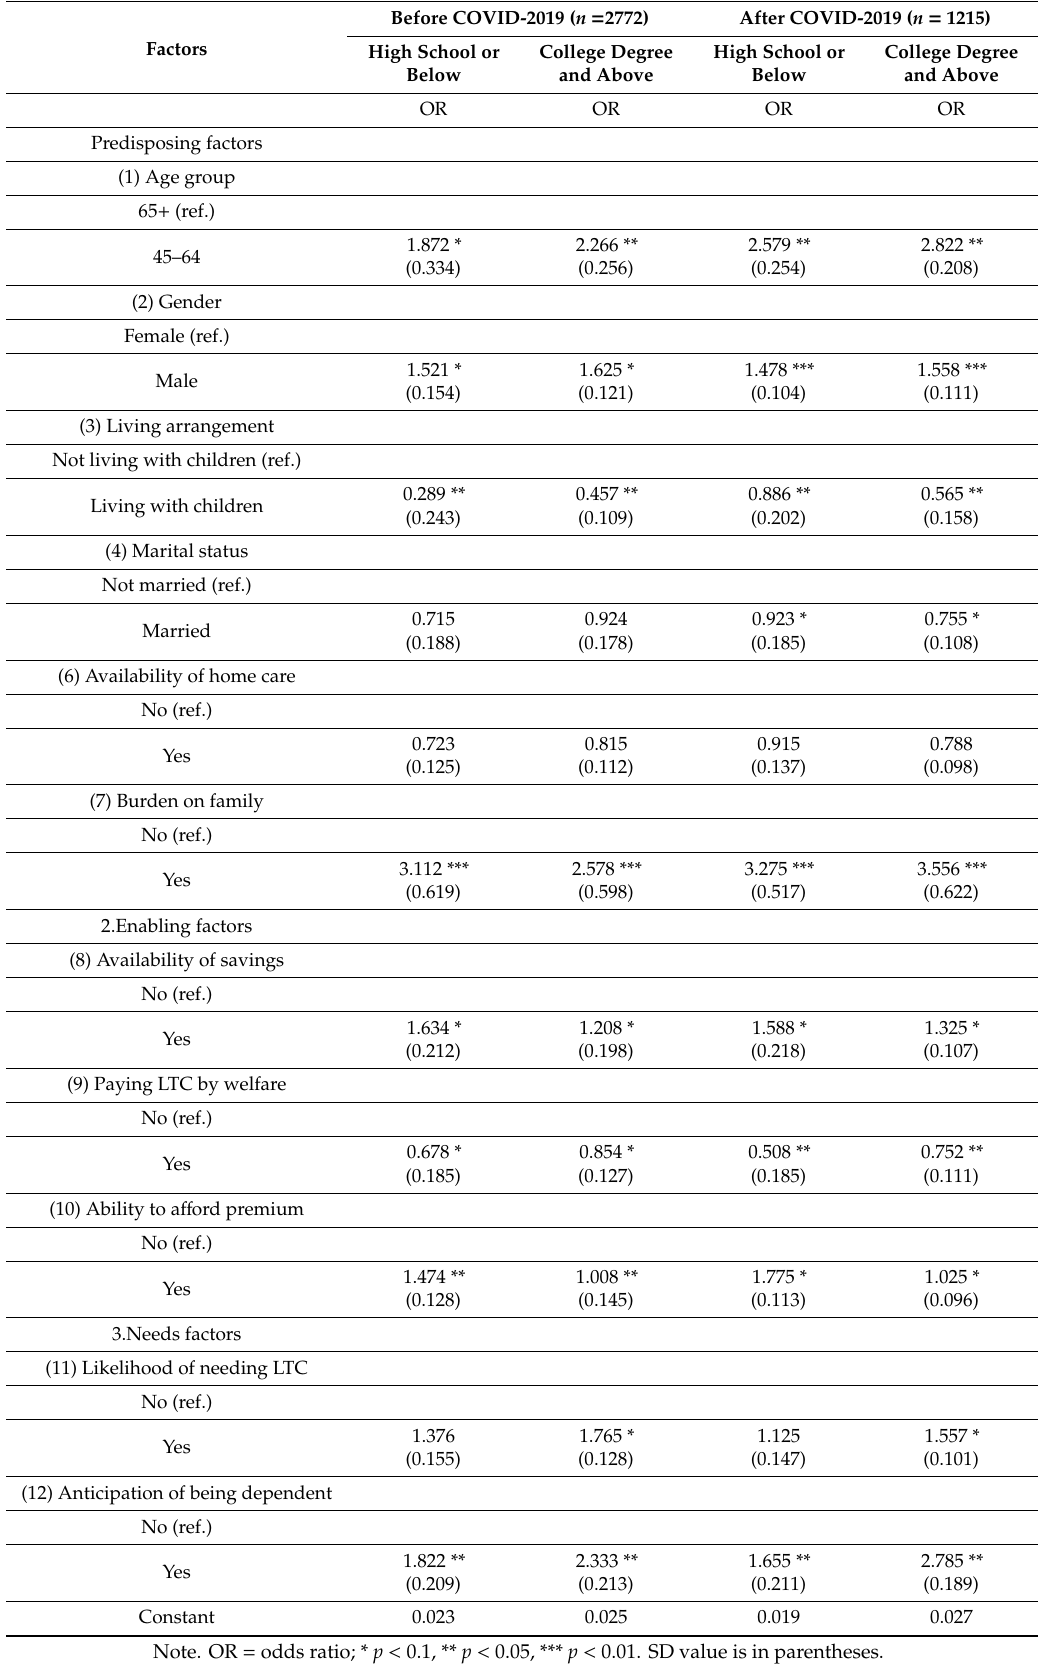
Table 4. Sub-multivariate analysis by educational